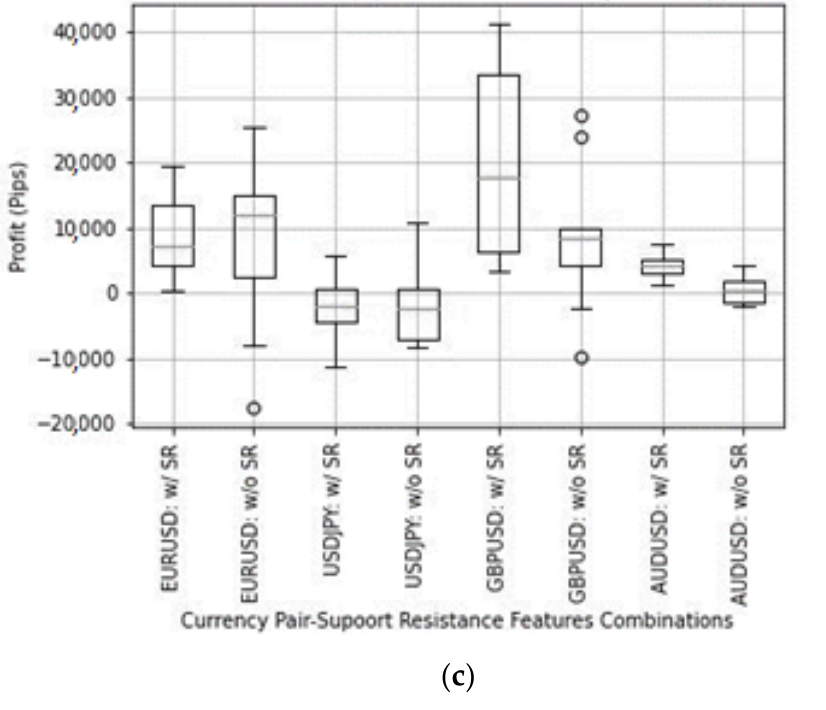
Figure 2. ( a ) Distribution of Precision of Models trained with and without SR Features; ( b ) Distribu- tion of F1-Score of Models trained with and without SR Features; ( c ) Distribution of Profitability of Models trained with and without SR Features.